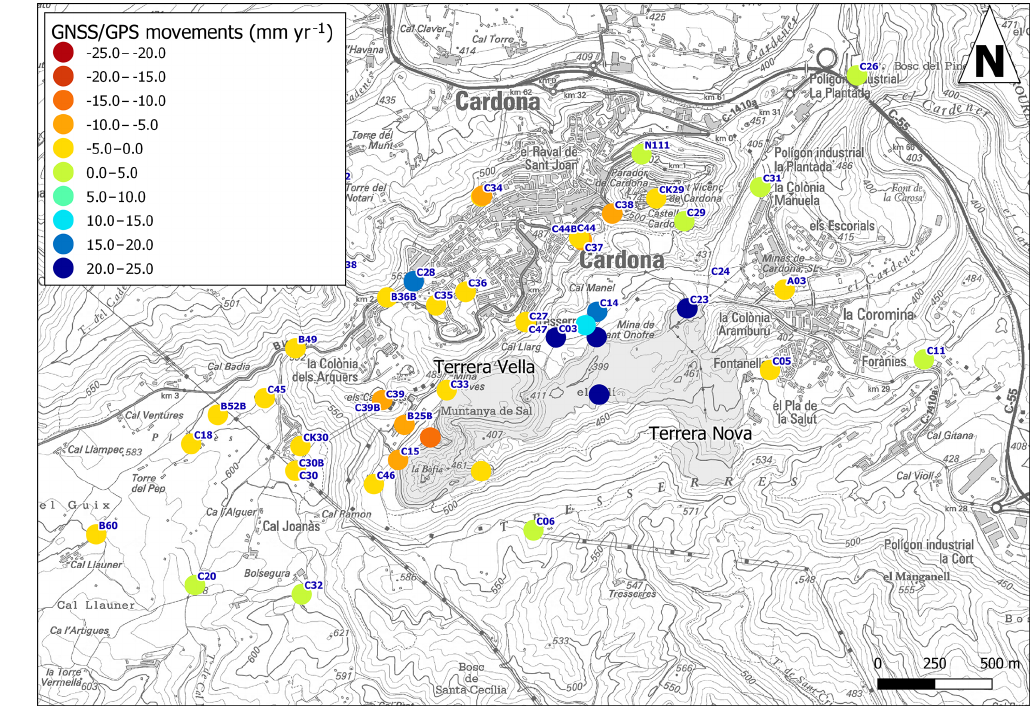
Figure 3. Terrain movement velocities obtained from the 20 year movement dataset of GNSS/GPS measures.